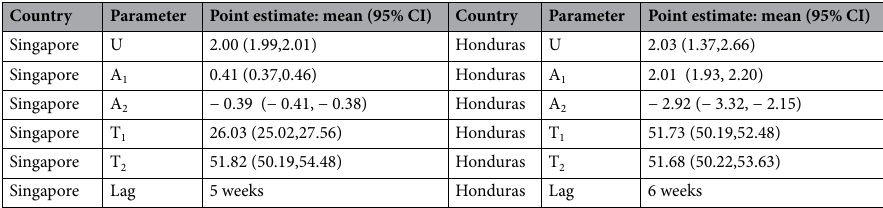
Table 3. Parameter estimates for the trigonometric seasonal models for beta shown for both countries.